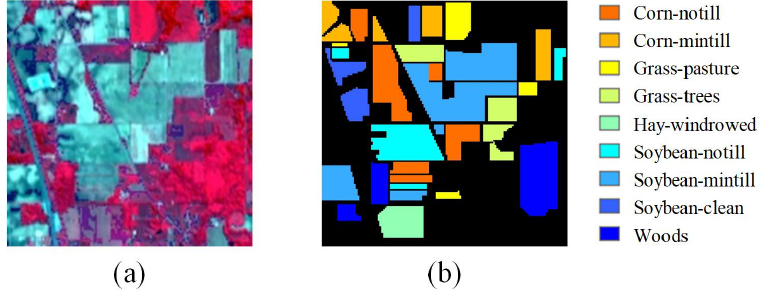
Figure 4. The Indian Pines scene: ( a ) false-color composite image; (b) ground truth.